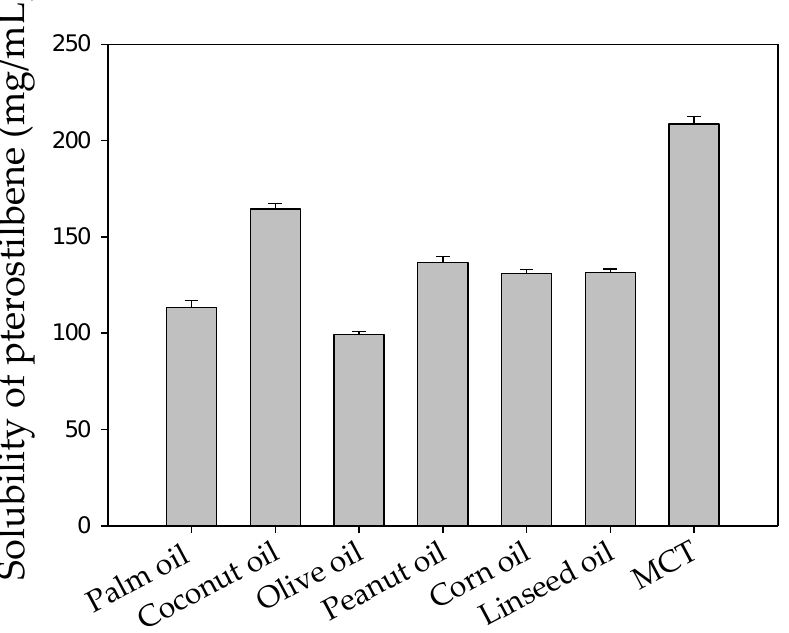
Figure 1. The solubility of pterostilbene in different kinds of oils. Data are presented as mean ± standard deviation ( n = 3).